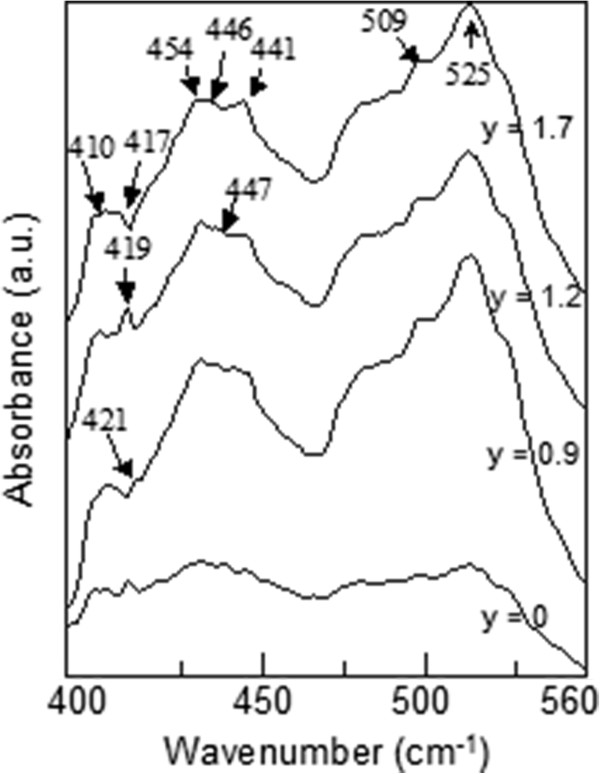
ATR IR spectra of n-type Ga0.68In0.32NyAs1 − y/GaAs QW samples with different N concentrations.